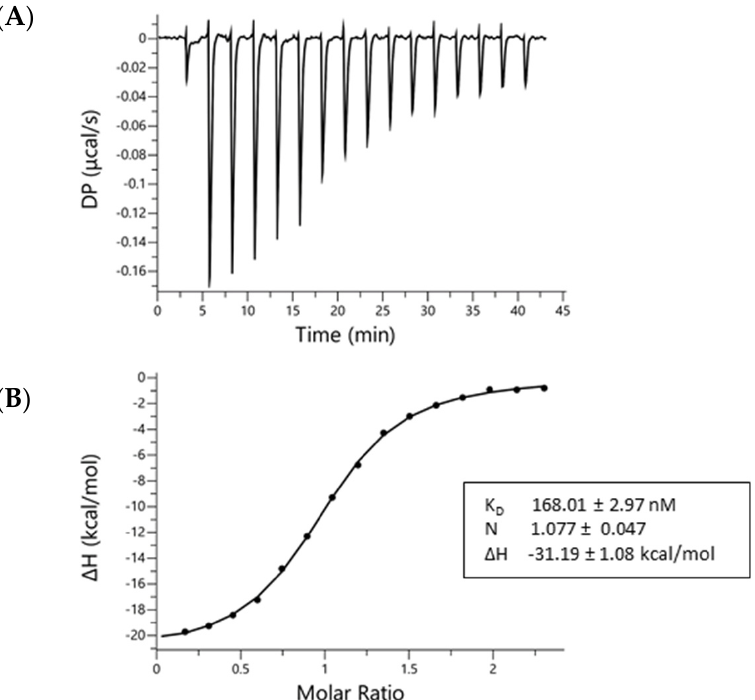
Figure 1. AZ67 binds to PFKFB3. Binding of AZ67 to PFKFB3 was analyzed via isothermal titration calorimetry using a MicroCal Peaq-ITC isothermal titration calorimeter. ( A ) Raw thermogram; ( B ) integrated injection heat (kcal/mol) as function of the molar ratio. The obtained fitted values in the box are the mean ± SEM of three replicates.